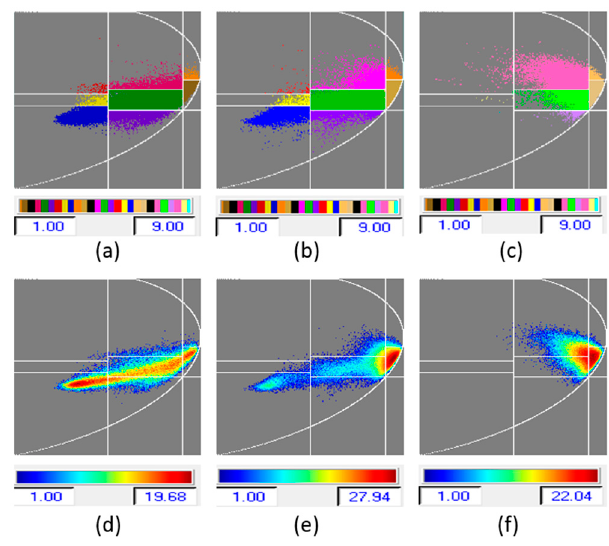
Figure 11. ( a – c ) segmented planes for H/ α / λ 1 , H/ α / λ 2 , and H/ α / λ 3 classification; ( d – f ) occurrence planes for H/ α / λ 1 , H/ α / λ 2 , and H/ α / λ 3 classification.